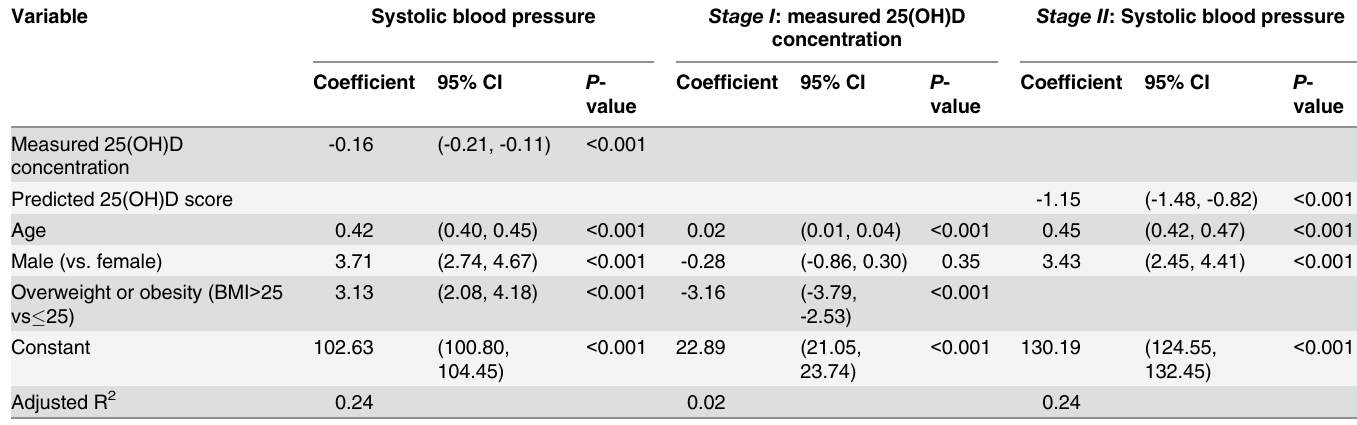
Table 4. Multivariable association between measured 25(OH)D concentration and systolic blood pressure; determinants of 25(OH)D concentration ( Stage I ); and multivariable association between predicted 25(OH)D score and systolic blood pressure ( Stage II ) among 4,002 adults of the Nation- al Health and Nutrition Examination Survey (2005 – 06), US,